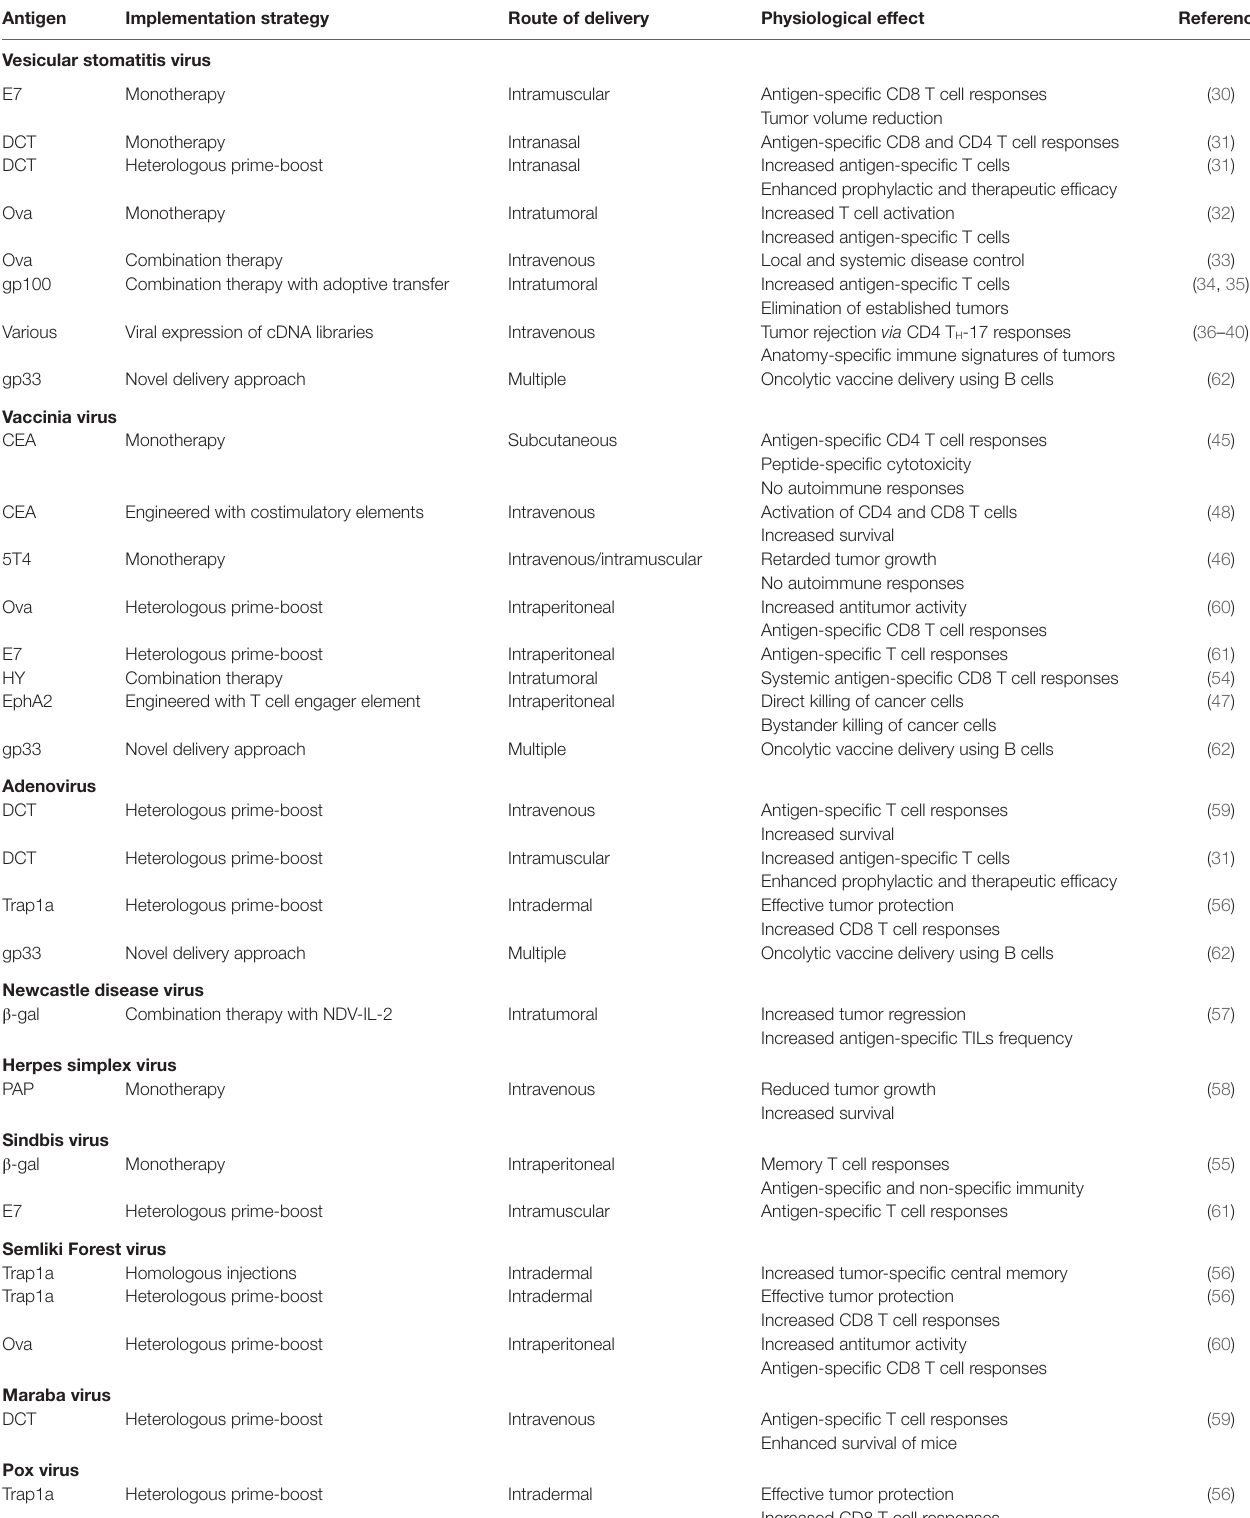
TABLe 1 | Summary of oncolytic vaccine studies using a variety of viral vectors targeting respective tumor antigens.